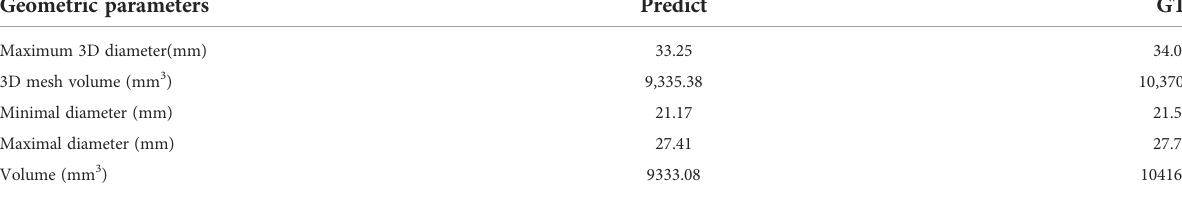
TABLE 3 Summary of geometric parameters between the prediction results and GT results.